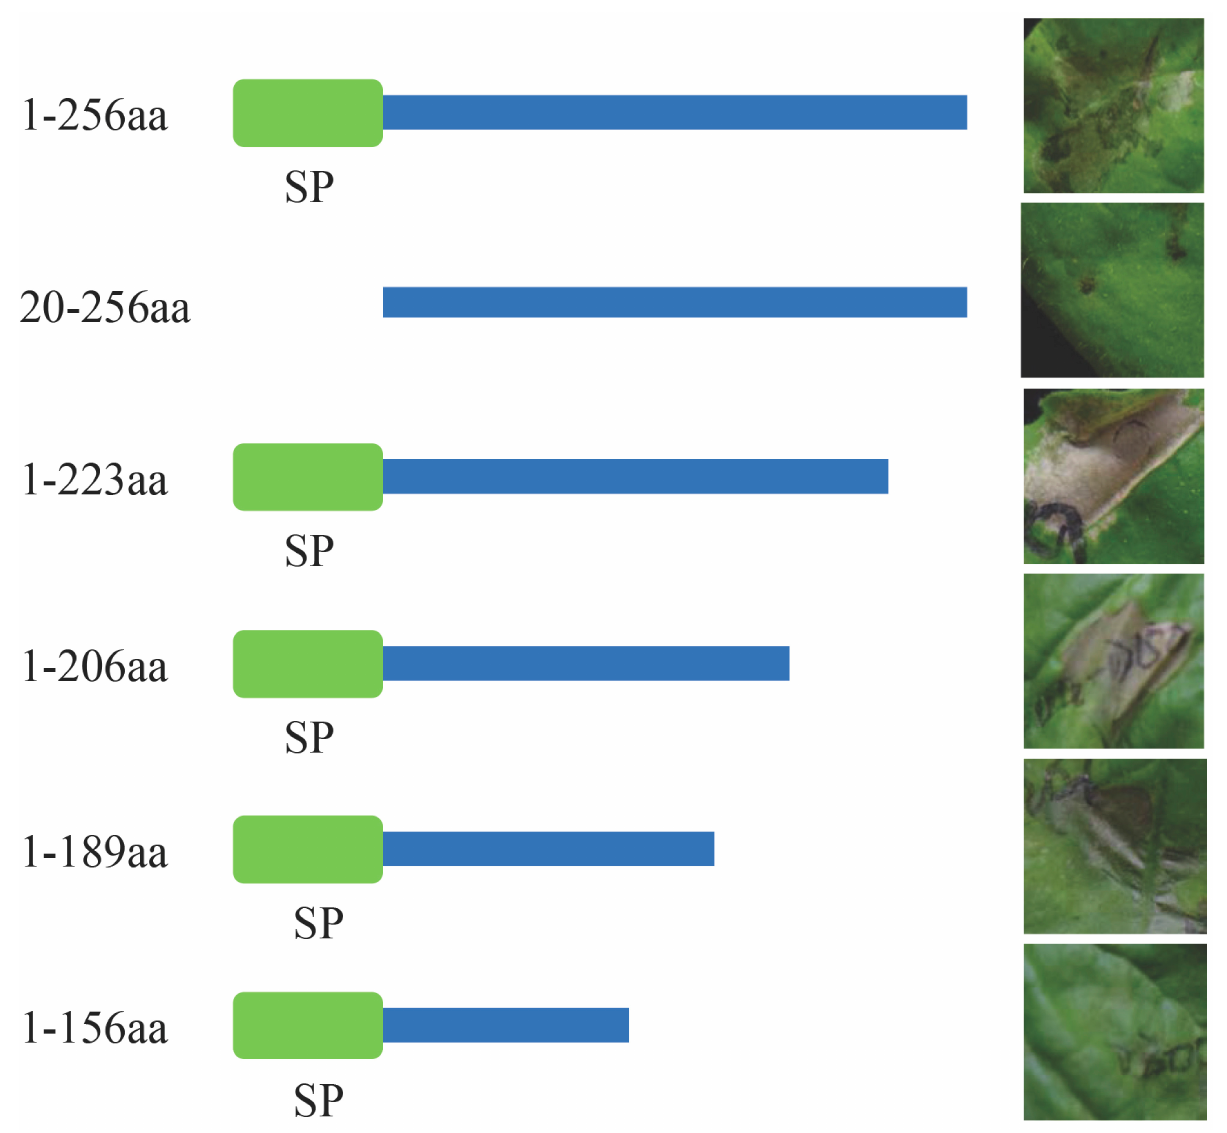
Figure 6. The 1-189 amino acid (aa) fragment of ThSCSP_12 is sufficient to induce cell death in Nicotiana benthamiana . Various truncated mutants of ThSCSP_12 were constructed and transiently expressed by agroinfiltration in N. benthamiana leaves. Photographs were taken 4 days after agro-infiltration.